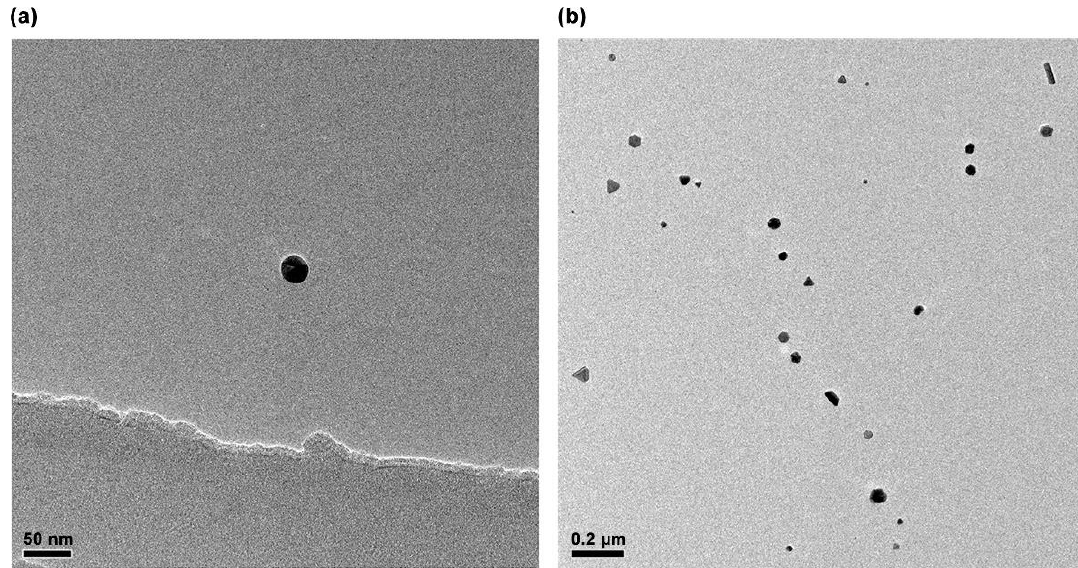
Figure 1. TEM image of Ag nanoparticles ( a ): the scale of 50 nm, ( b ): the scale of 0.2 µ m.